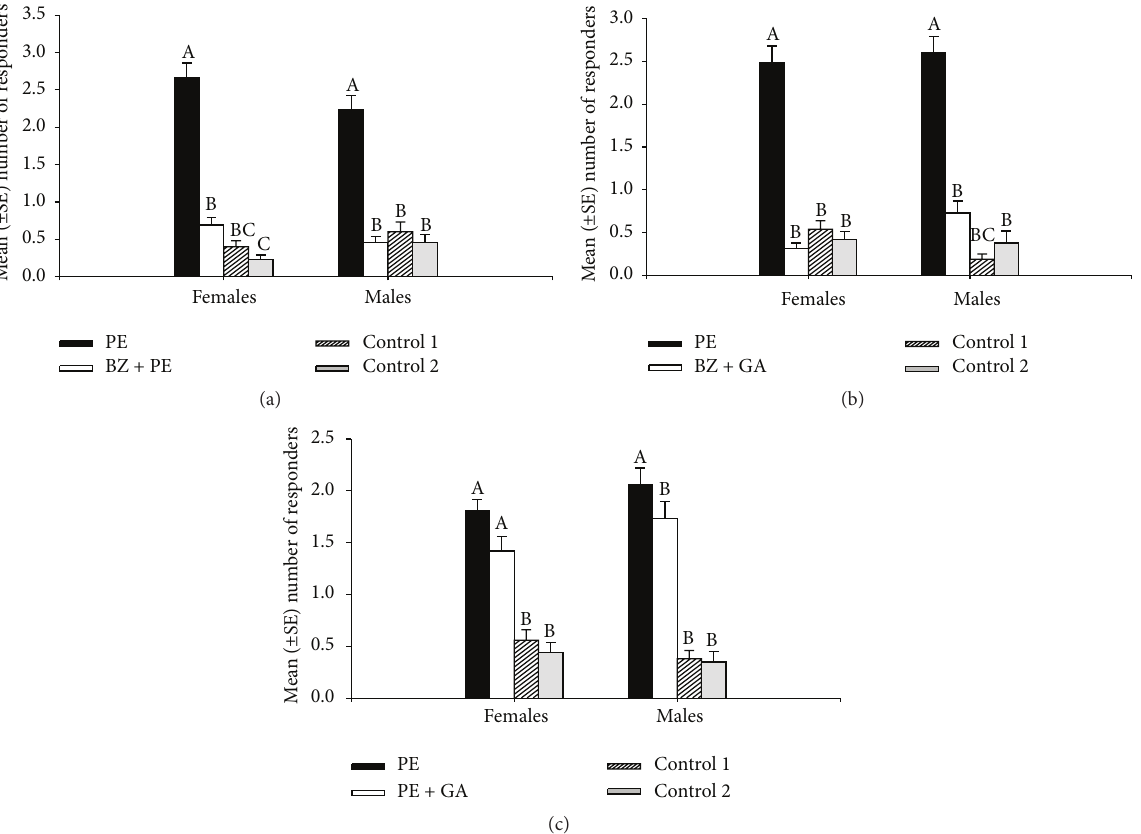
Figure2:Responseofplumcurculiotocombinationsofcommercialluresofbenzaldehyde(BZ),plumessence(PE),andgrandisoicacid(GA) in four-choice olfactometer bioassays. In each binary test, PE was compared against any two combinations of the three lures: (a) PE versus BZ + PE, (b) PE versus BZ + GA, and (c) PE versus PE + GA. Groups of five weevils of either sex were released per test in the olfactometer and replicated six times. Means for each sex having no letter in common are significantly different (ANOVA, Tukey-Kramer HSD, 𝑃 < 0.05